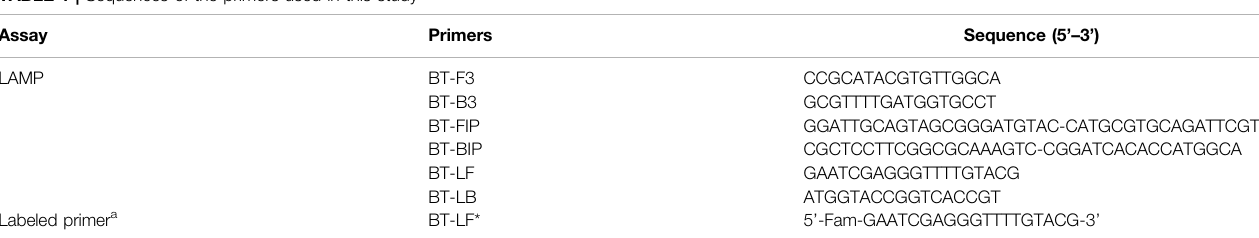
TABLE 1 | Sequences of the primers used in this study Assay Primers Sequence (5 ’– 3 ’ )